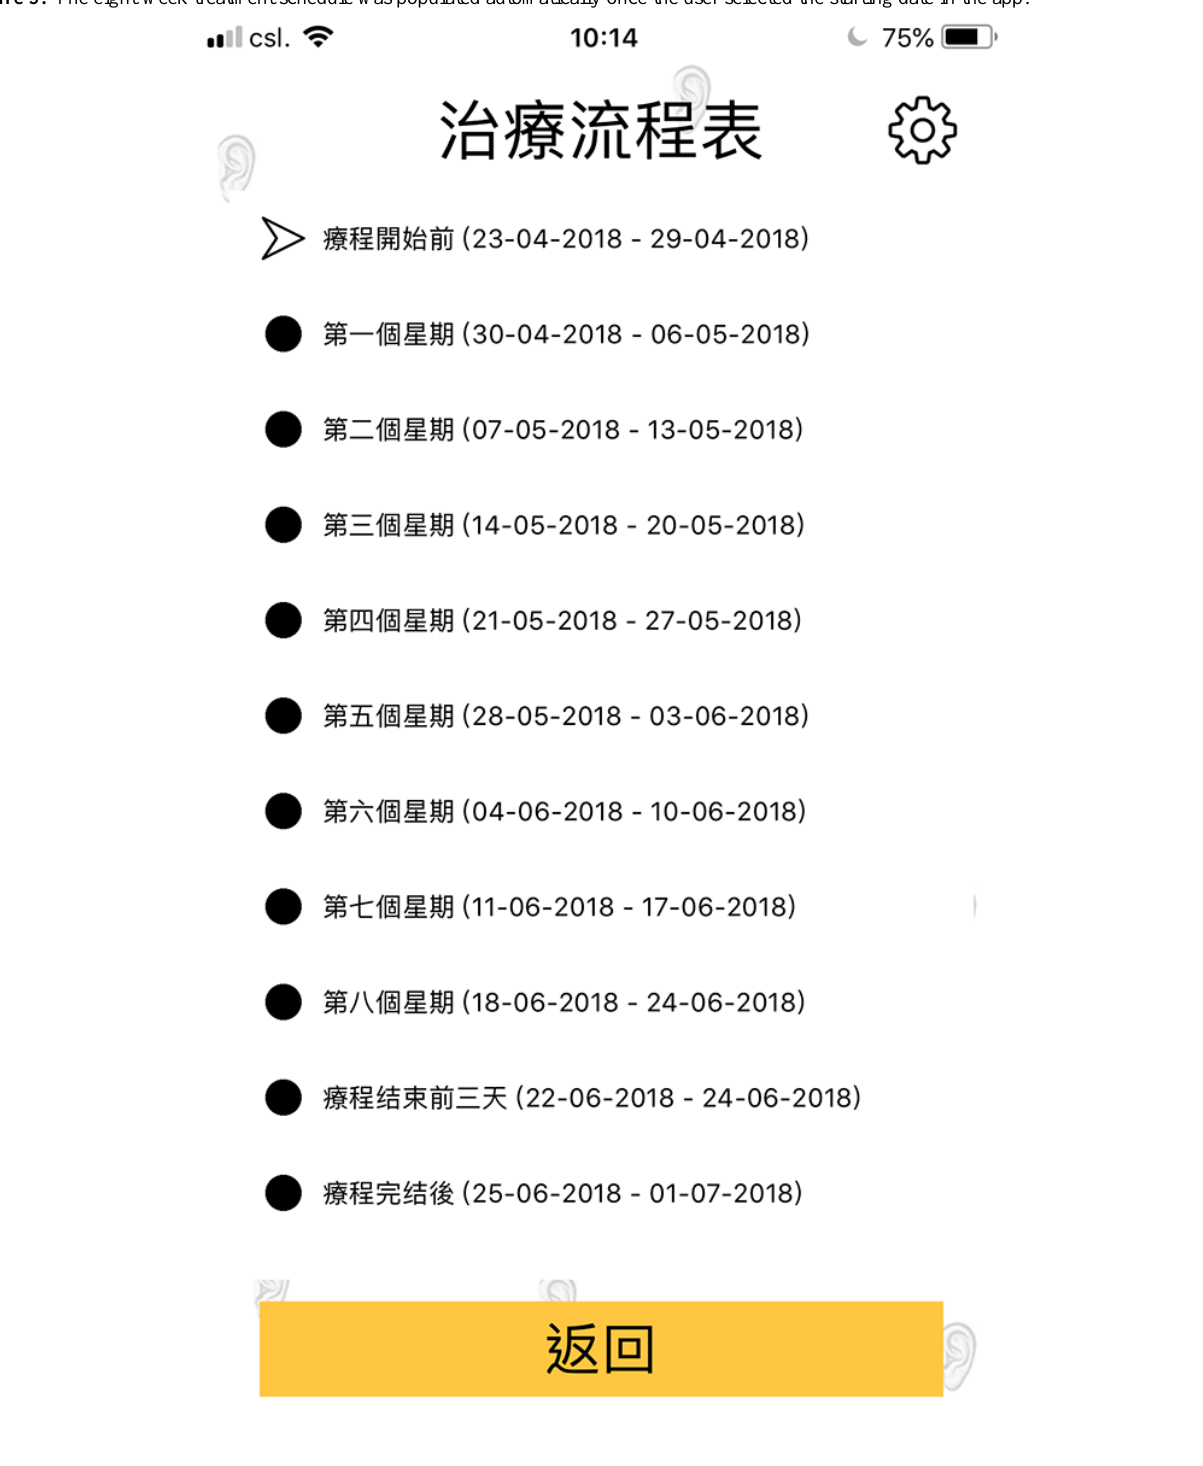
Figure 5. The eight-week treatment schedule was populated automatically once the user selected the starting date in the